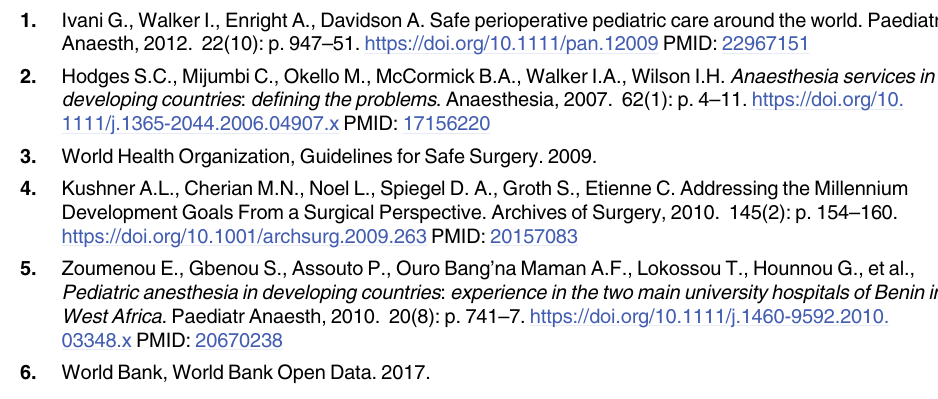
S1 Fig. Distribution of structure index score. S2 Fig. Distribution of process index